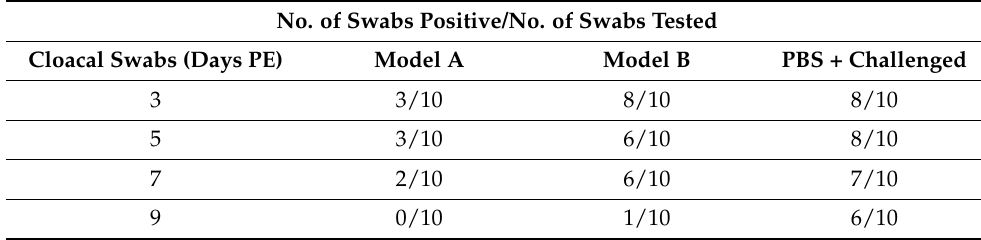
Table 2. Virus isolation from oral swabs of exposed chickens in models A and B ( n = 10). No. of Swabs Positive/No. of Swabs Tested Oral Swabs (Days PE) Model A Model B PBS + Challenged 3 4/10 7/10 9/10 3/10 2/10 5/10 6/10 0/10 0/10 5/10 PE, post-exposure. Table 3. Virus isolation from cloacal swabs of exposed chickens in models A and B ( n = 10). No. of Swabs Positive/No. of Swabs Tested Cloacal Swabs (Days PE) Model A Model B PBS + Challenged